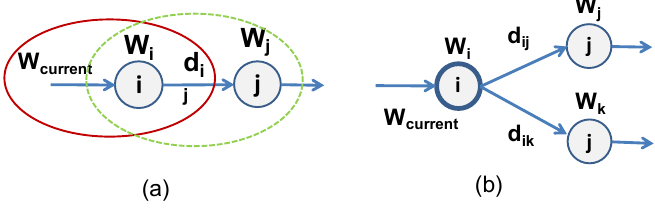
Figure 5. Features of the Target Metric: Generic instance between two nodes i and j ( a ); and a greedy decision based on this metric ( b